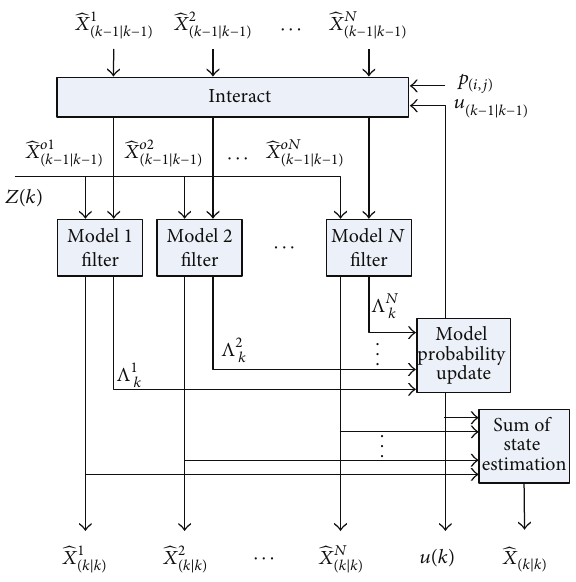
Figure 2: The IMM algorithm